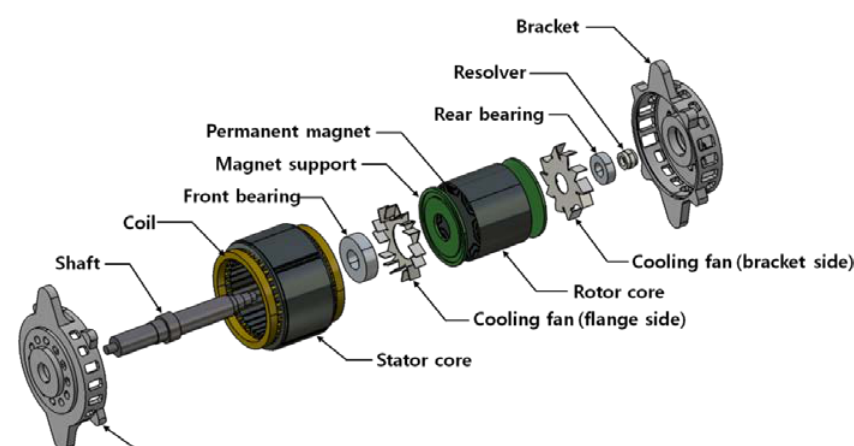
Figure 2. Analysis model of ISG